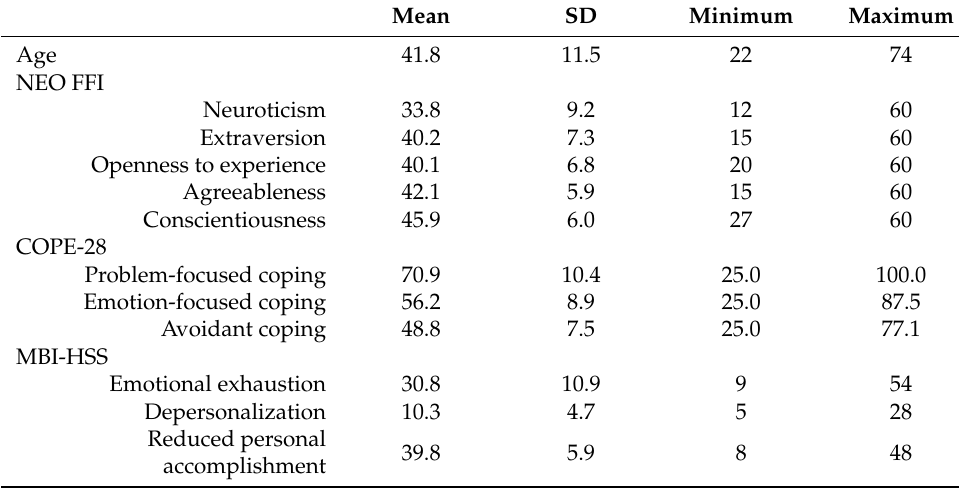
Table 2. Descriptive statistics for age and the scores obtained in the Five-Factor Reduced Personality Inventory (NEO FFI), the Brief Cope Inventory (COPE-28), and the Malasch Burnout Inventory- Human Services Survey